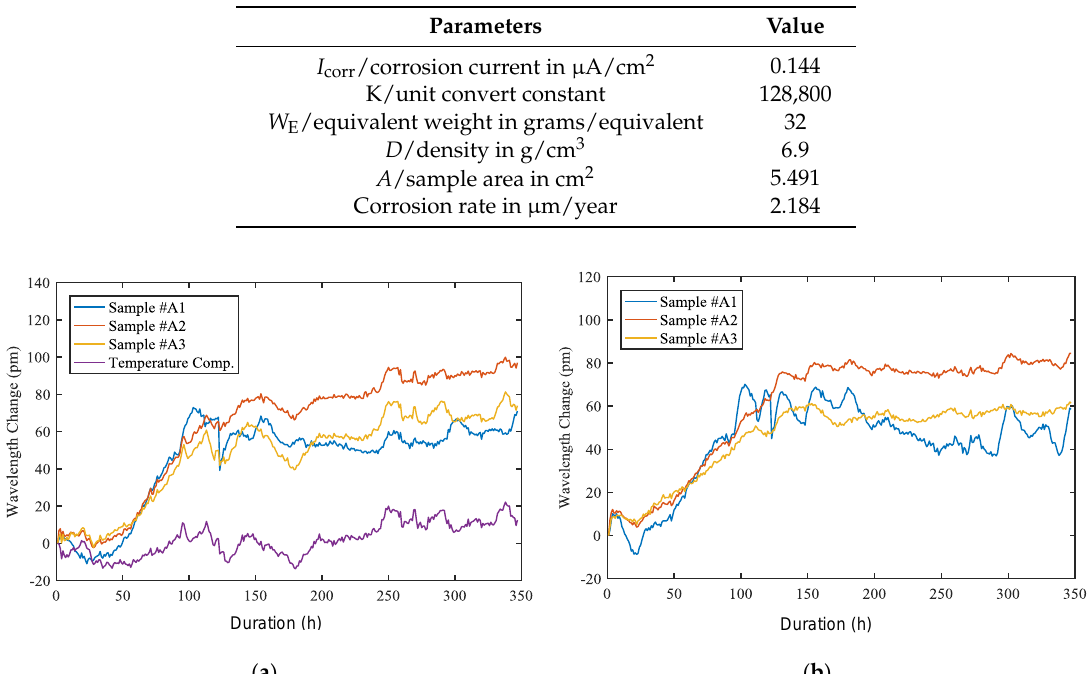
Table 4. Parameters used for corrosion rate calculation in wire arc sprayed Al-Zn coated sample.